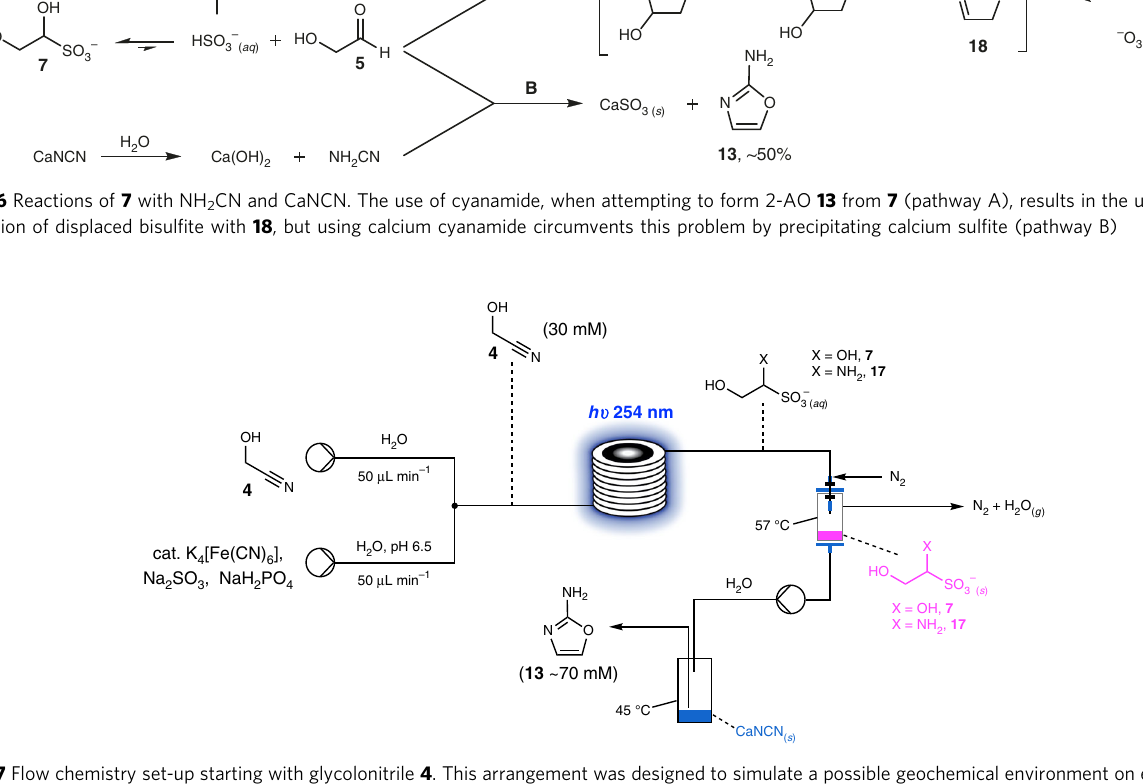
Fig. 7 Flow chemistry set-up starting with glycolonitrile 4 . This arrangement was designed to simulate a possible geochemical environment on early Earth (see main text). Initial concentrations: glycolonitrile 4 (60 mM), Na 2 SO 3 (200 mM), NaH 2 PO 4 (50 mM) and K 4 [Fe(CN) 6 ] (10